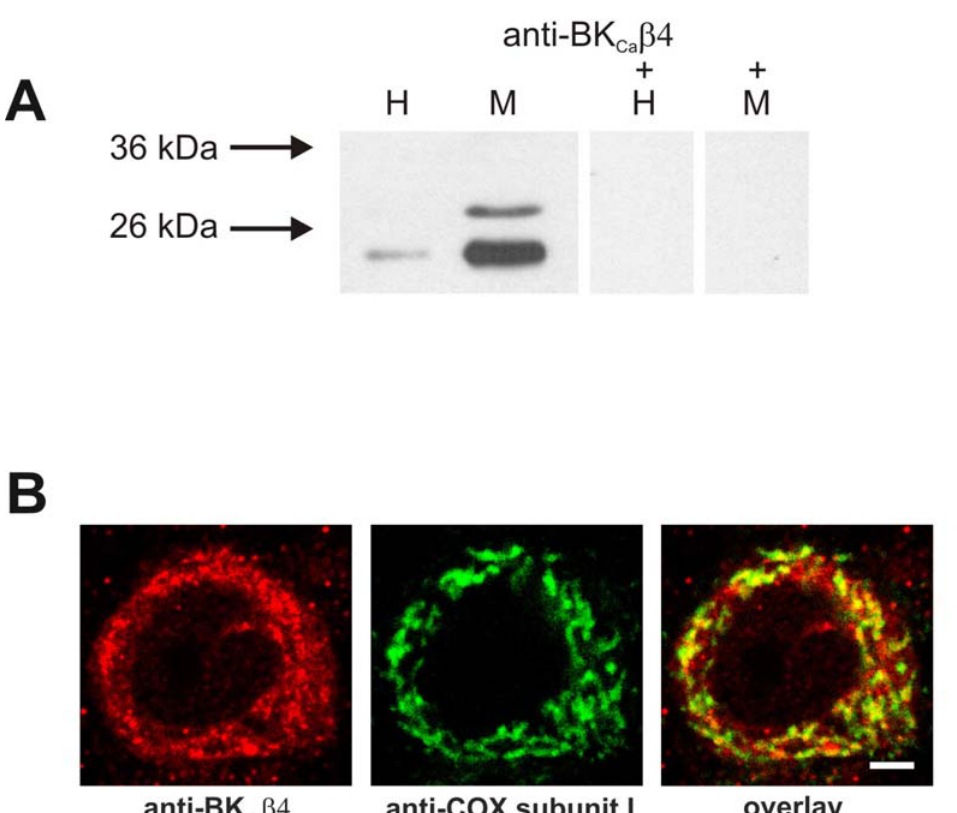
β subunit in rat brain Ca 4